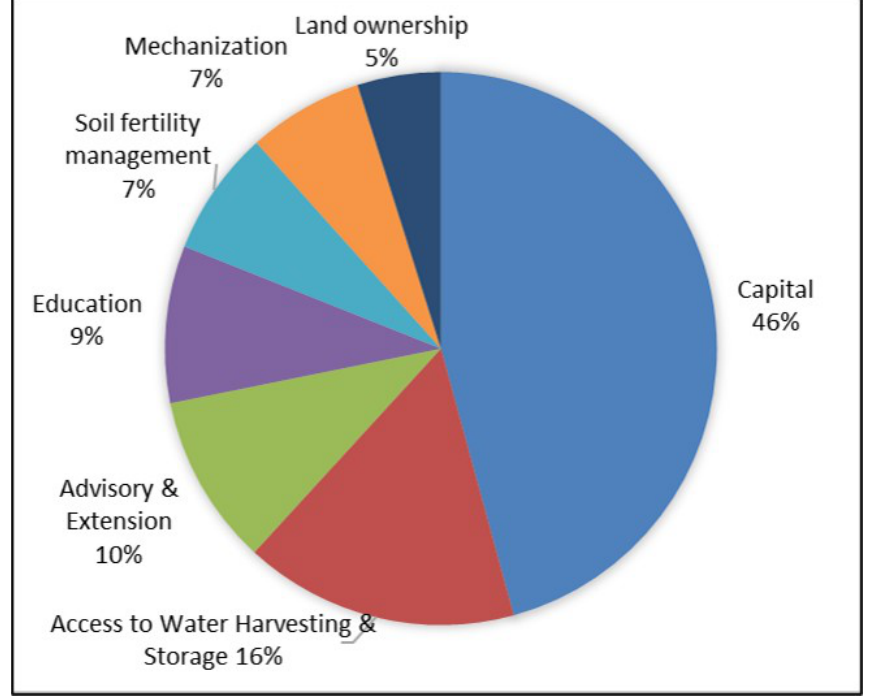
Figure 13. Farmers’ perceived adaptation